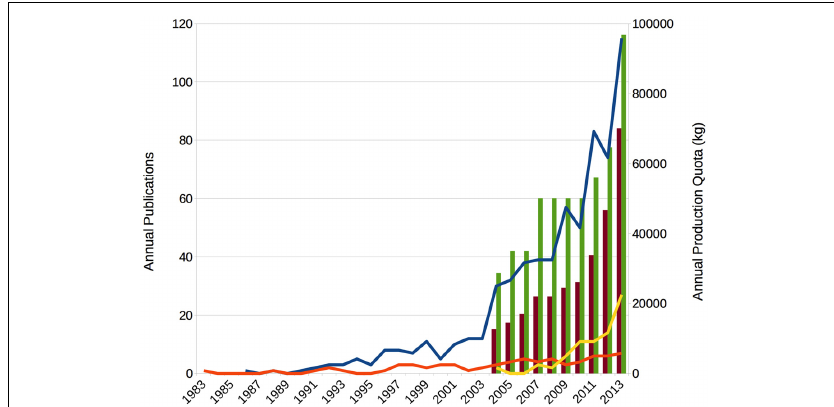
FIGURE 1 | Stimulant production and enhancement papers increased strongly. Lines show a steep increase in publications on cognitive enhancement (blue) and neuroenhancement (yellow), but only modestly on mood enhancement (orange). Publication numbers are based on a Web of Science topic search. Bars show a strong increase in production quotas for amphetamine (red) and methylphenidate (green). In the shown 10-year period from 2004 to 2013, the former increased 5.5-fold, the latter 3.4-fold, after quotas had already been increasing in the 1990s (not shown, but see Rasmussen, 2008). Figures based on US Drug Enforcement Agency, October 2, 2013, http://www.deadiversion.usdoj.gov/quotas/quota_history.pdf (accessed May 30, 2014), accumulating amphetamine produced for sale and